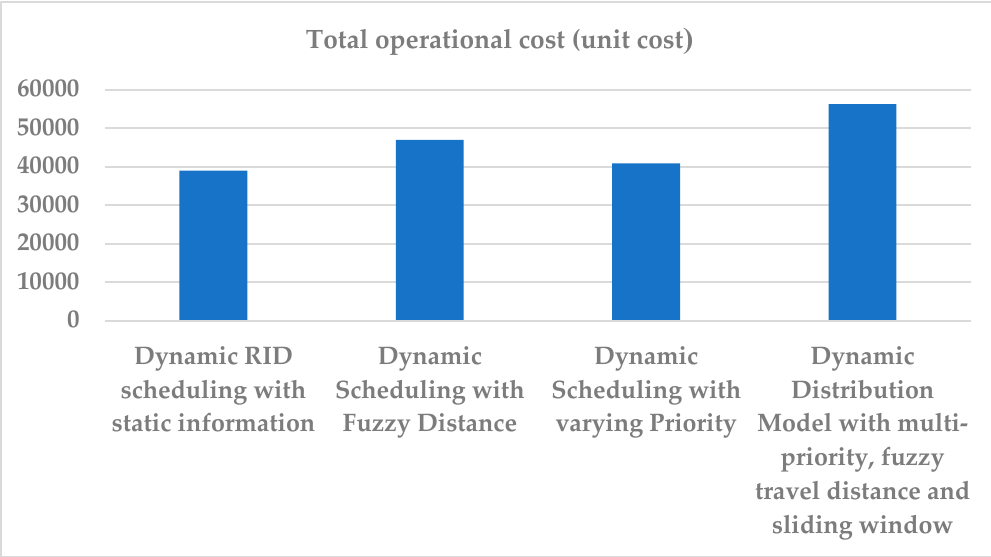
Table 7. Optimum distribution sequence of RID models. Distribution Model Demand Sequence: (Di: Disaster Regions) Static RID model with limited vehicles